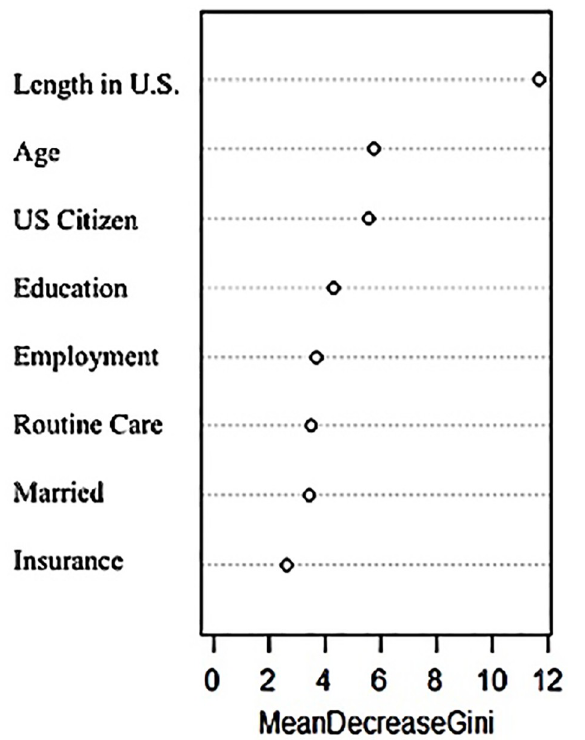
Fig 4. Random Forest (RF) important variables. Results of RF variables of importance are featured including order of ranked